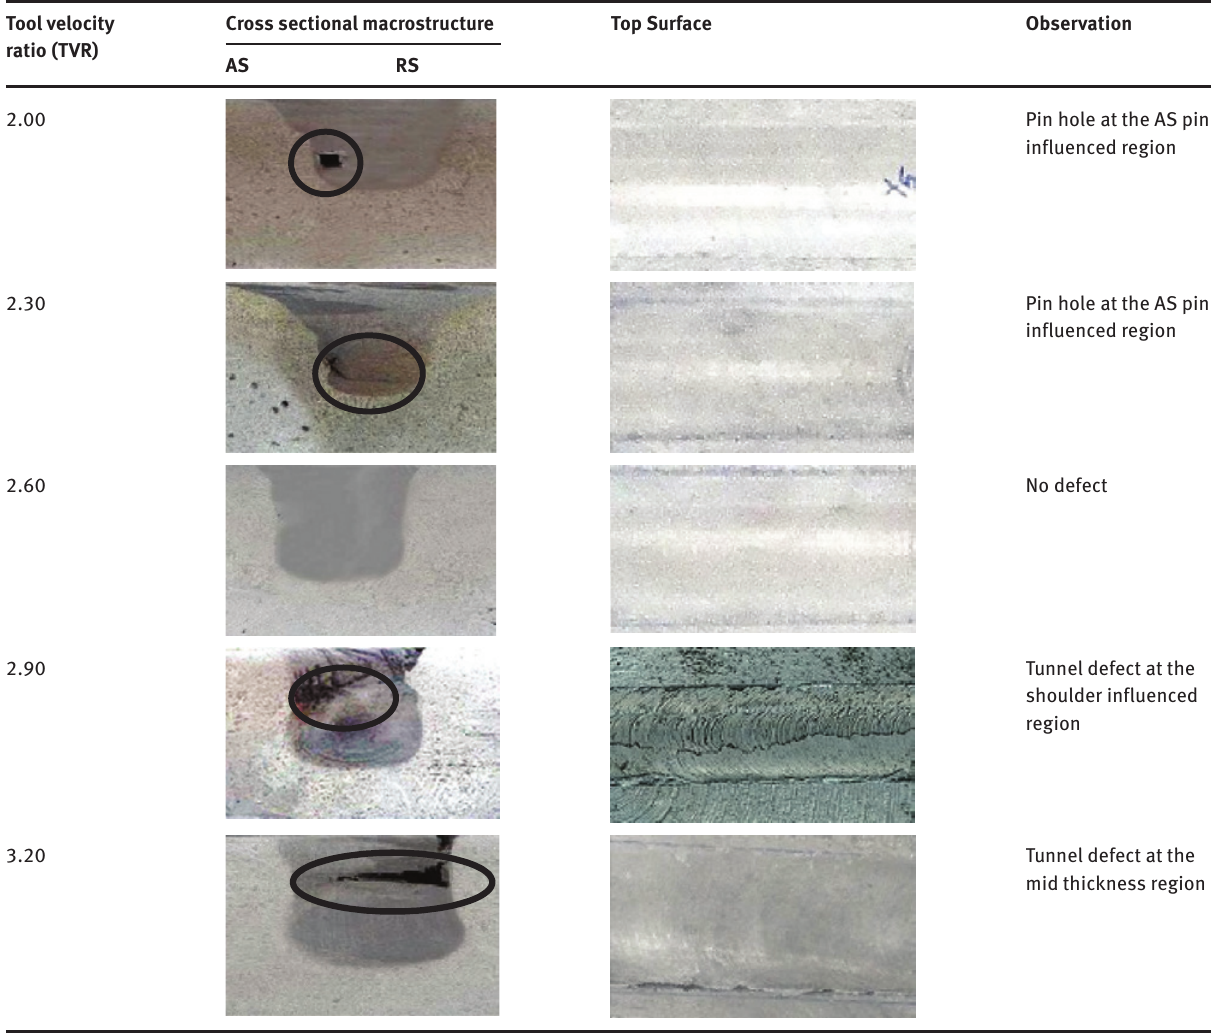
Table 3: Effect of TVR on